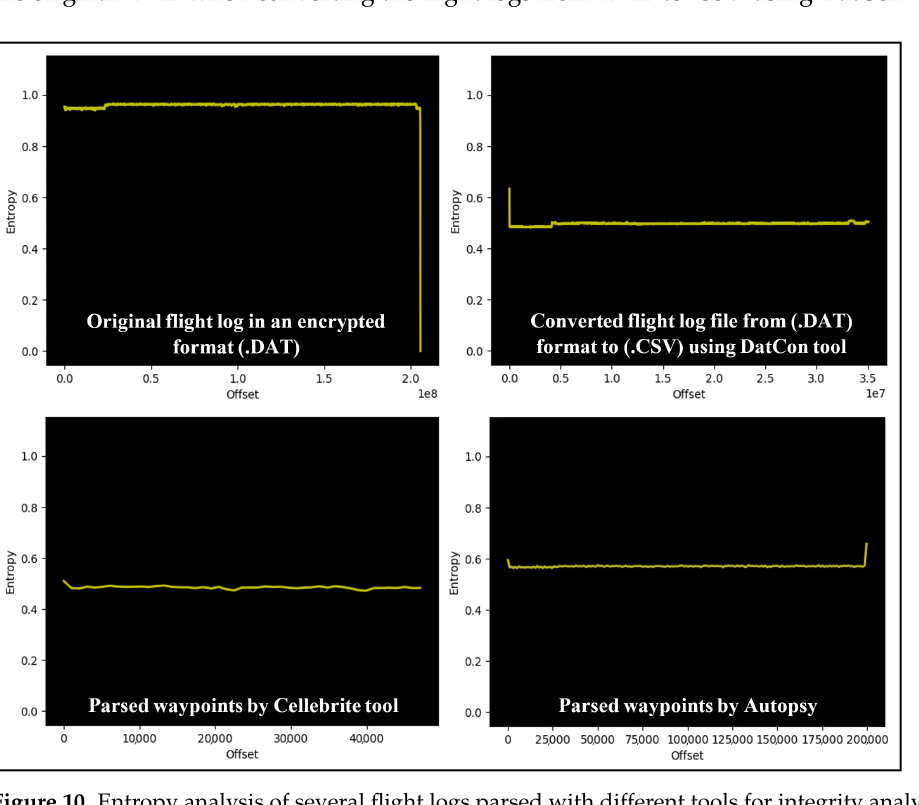
Figure 10. Entropy analysis of several flight logs parsed with different tools for integrity